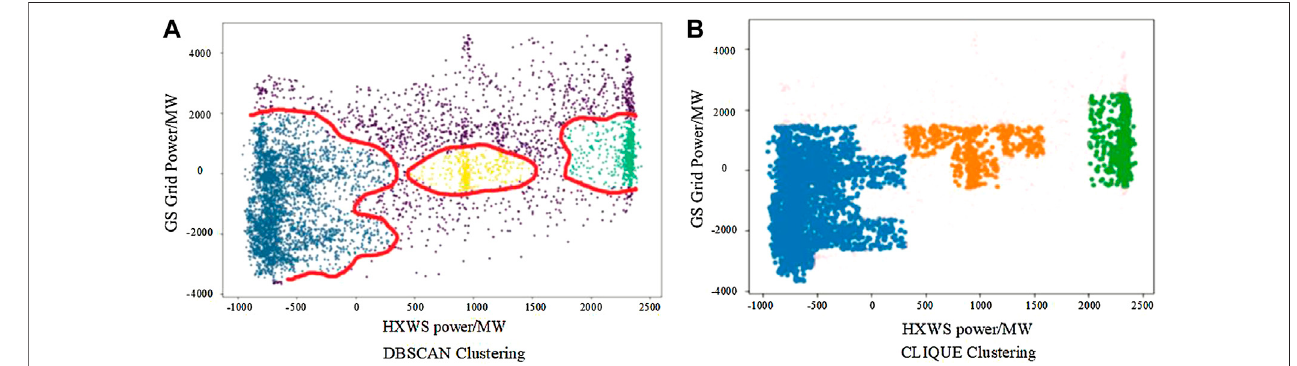
FIGURE 6 | DBSCAN and CLIQUE clustering effect.